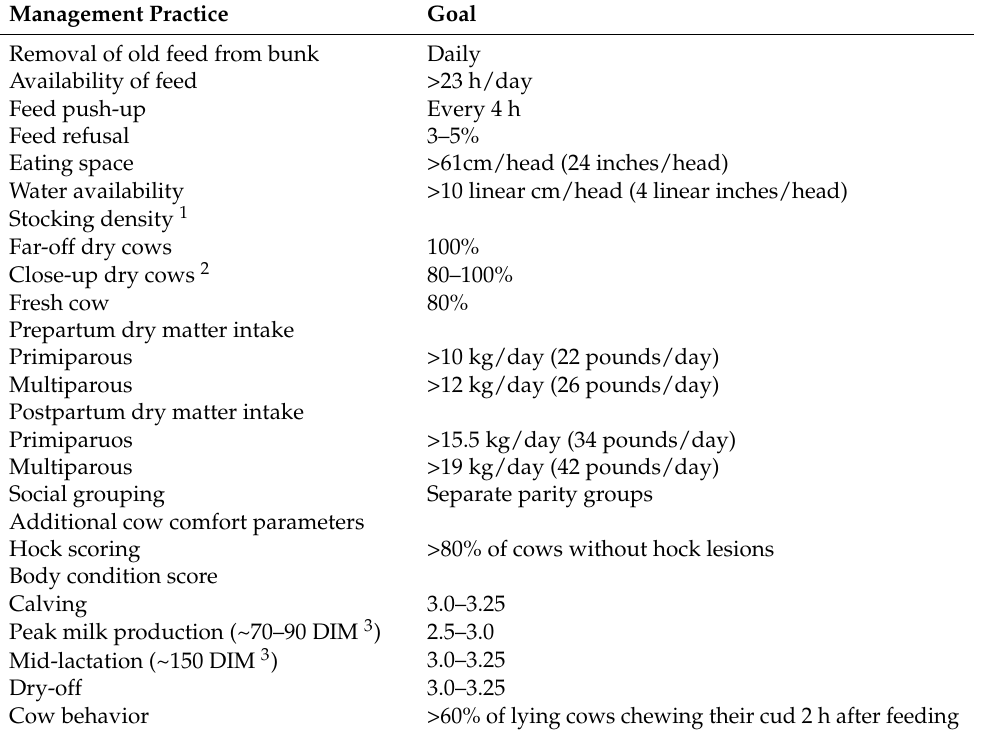
Table 1. Recommended feeding, bunk management, and management practices during the transi- tion